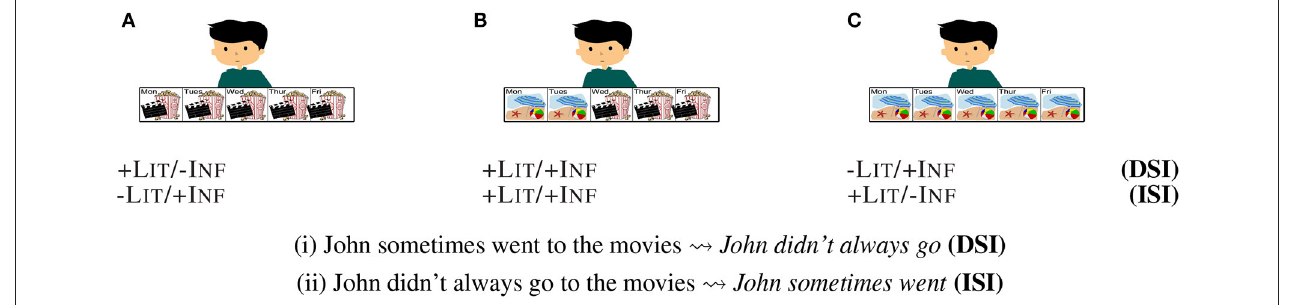
FIGURE 3 | Target Picture versions and conditions for Experiment 1: “ + L IT / − I NF ” for DSI & “ − L IT / + I NF ” for ISI (A) , “ + L IT / + I NF ” for DSI & ISI (B) , “ − L IT / + I NF ” for DSI & “ + L IT / − I NF ” for ISI (C)